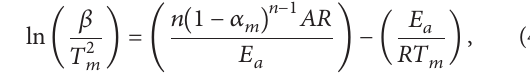
C/min1000/ T (K) 12 ◦ tmhd at various heating ( ) 4